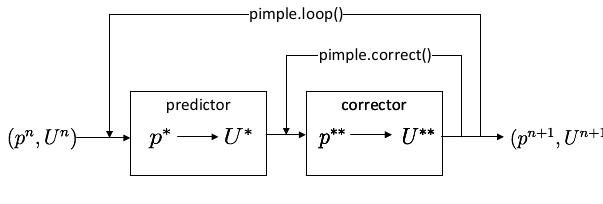
Figure 2. The trace of the fields in the PIMPLE algorithm from time step n to time step n +